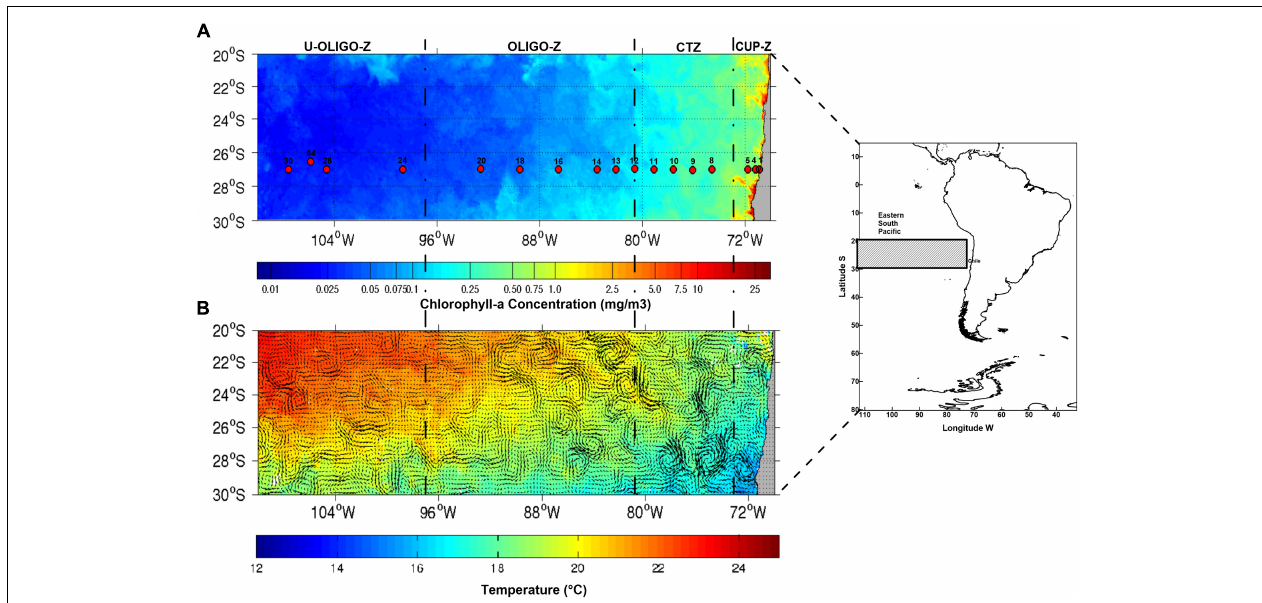
FIGURE 1 | The eastern south Pacific region where the CIMAR-21 cruise was carried out in October 2015: (A) representation of the sampling stations across the four study zones defined from satellite chlorophyll-a levels as: coastal upwelling area (CUP-Z), the mesotrophic coastal transition zone (CTZ), the oligotrophic area (OLIGO-Z) and the ultra-oligotrophic region (U-OLIGO-Z), (B) satellite surface temperature and geostrophic surface currents during the cruise.